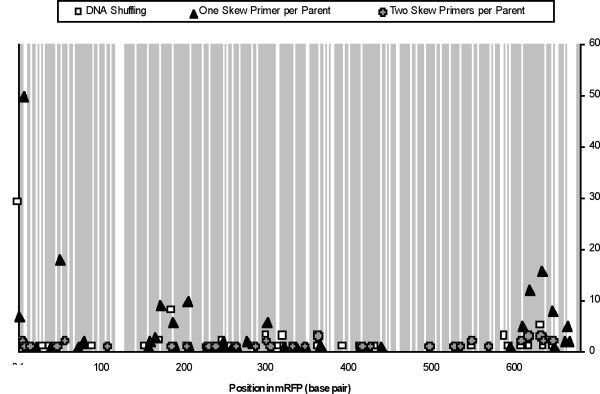
Combined plot of the frequency and location of crossovers in libraries made from DsRed and mRFP. Shading indicates that bases are identical in DsRed and mRFP; white space indicates that bases differ. Crossovers are denoted at the position where the first base pair differs between the two sequences. Sequences with multiple crossovers were marked at each crossover position separately. 'One skew primer per parent' combines the results from RD-PCR1-4. Subplots of Figure 4 can be found in additional file 2.